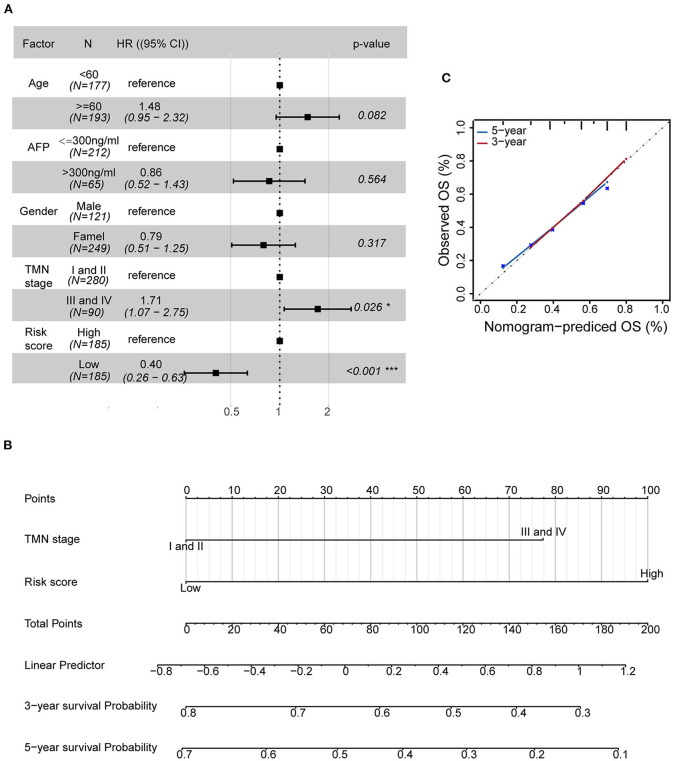
Establishment of a nomogram containing independent factors of OS prediction. (A) The forest plot based on clinical characteristics and the five-AR-lncRNA signature by multivariate Cox regression analysis. CI, confidence interval; HR, hazard ratio. (B) A prognostic nomogram predicting 3- and 5-year OS outcomes of HCC based on TNM stage and the risk score of the five-AR-lncRNA signature. (C) Calibration curves for the nomogram of 3- (red) and 5-year (blue) OS prediction for the whole set of HCC patients.